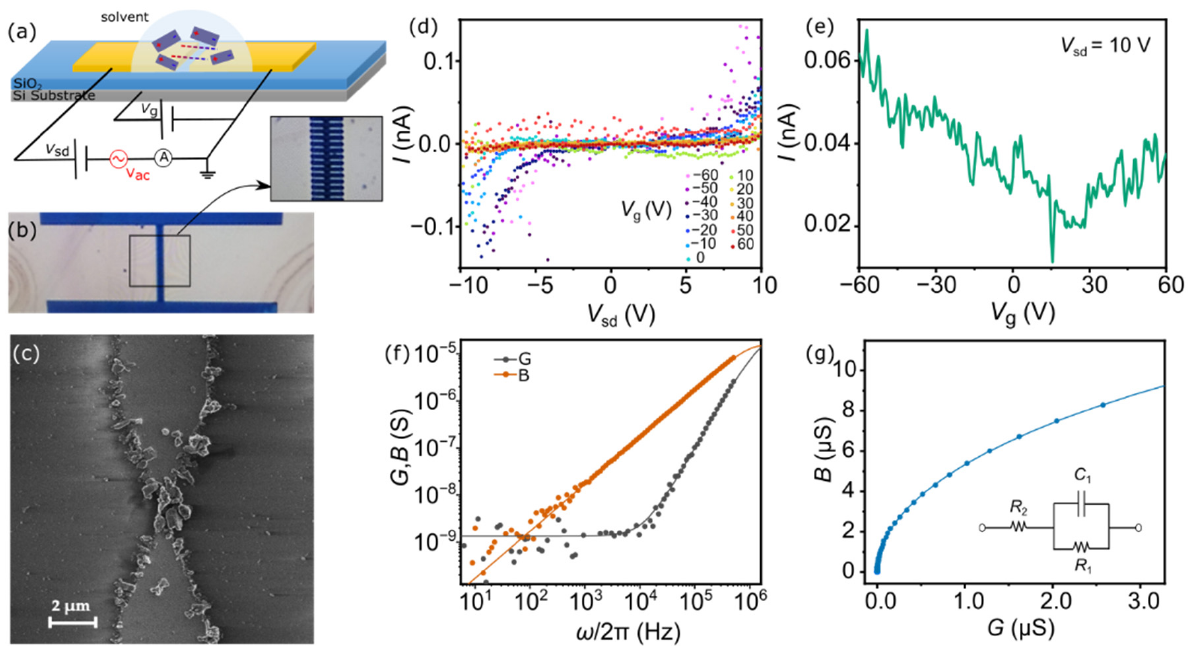
Figure 4. DEP assembly of LPE cylindrite. ( a ) Schematic representation of the DEP of colloidal heterostructures between metallic electrodes. ( b ) Optical image of a multi-electrode device. ( c ) SEM image of a single pair of electrodes after DEP. Several cylindrite flakes bridge the gap between the electrodes. ( d ) Current–voltage ( I – V sd ) characteristic measured at different gate voltages after DEP assembly. ( e ) Current as a function of the applied back-gate voltage V g at a fixed V sd = 10 V. ( f ) G and B frequency spectrum measured on a cylindrite-based FET. Solid lines are G and B simulations using a R 2 - C 1 R 1 model (see text). ( g ) Nyquist representation of the complex admittance. The inset shows the equivalent R-CR circuit used to model the